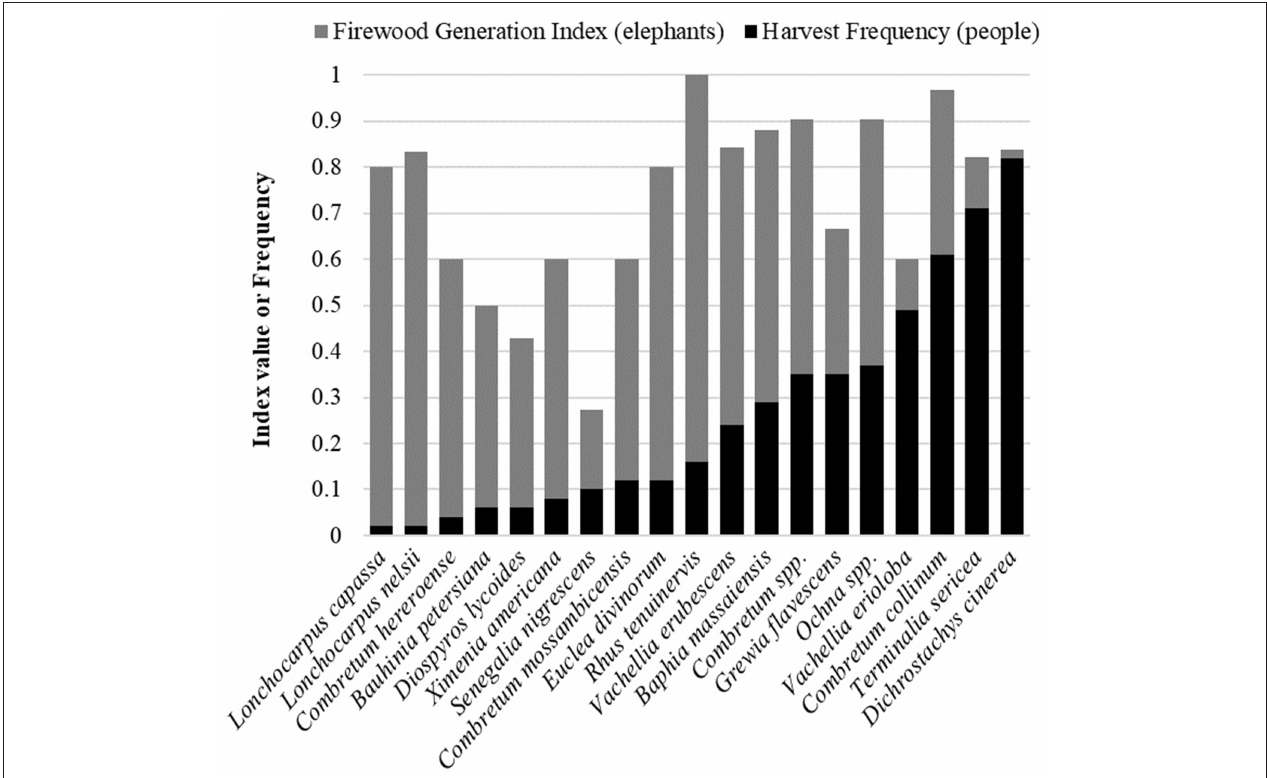
FIGURE 2 | Plot of the frequency of firewood collection by people and the elephant firewood generation index value for each tree species. All tree species found in at least five vegetation plots were included. Species are ordered by increasing frequency of firewood harvest by people.